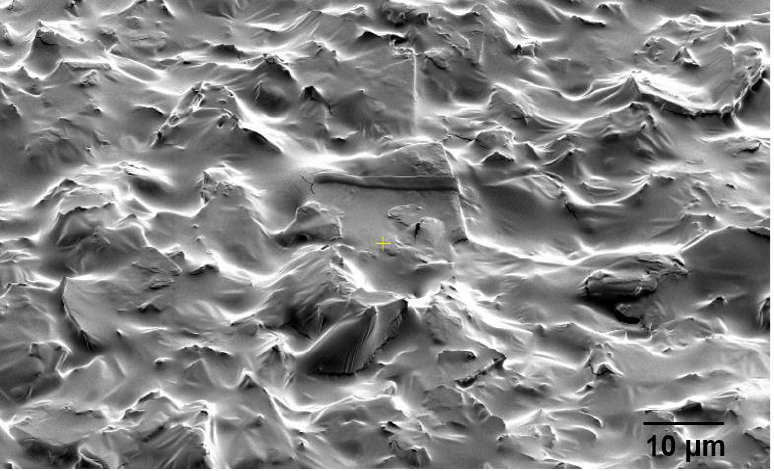
Figure 8. BSE cross-sectional SEM images of ( a ) bare Si 3 N 4 -on-silicon substrate, and samples doped with Er-TZN into Si 3 N 4 -on-silicon when substrate was heated at ( b ) 470 °C (K470) ( c ) 520 °C (K520), Table 4. The thickness of the upper layer and Si 3 N 4 underneath, as measured by SEM for samples K470, K520, K570, K600, and K650.